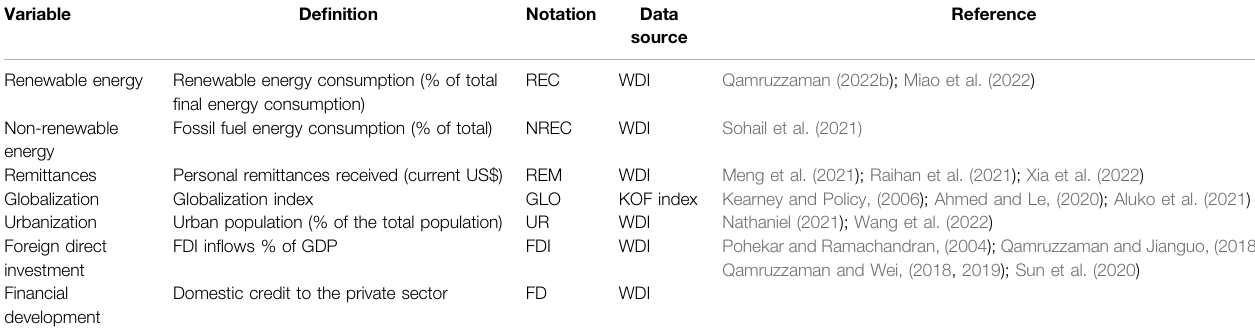
TABLE 1 | Variables de fi nition and data